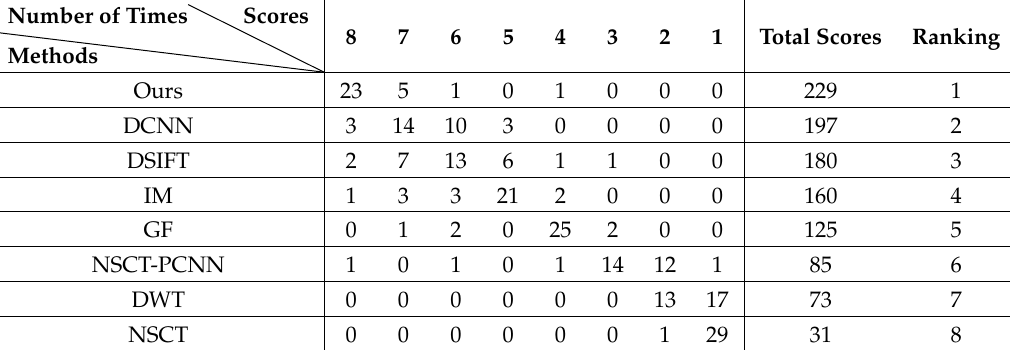
Table 4. Scores and rankings of the